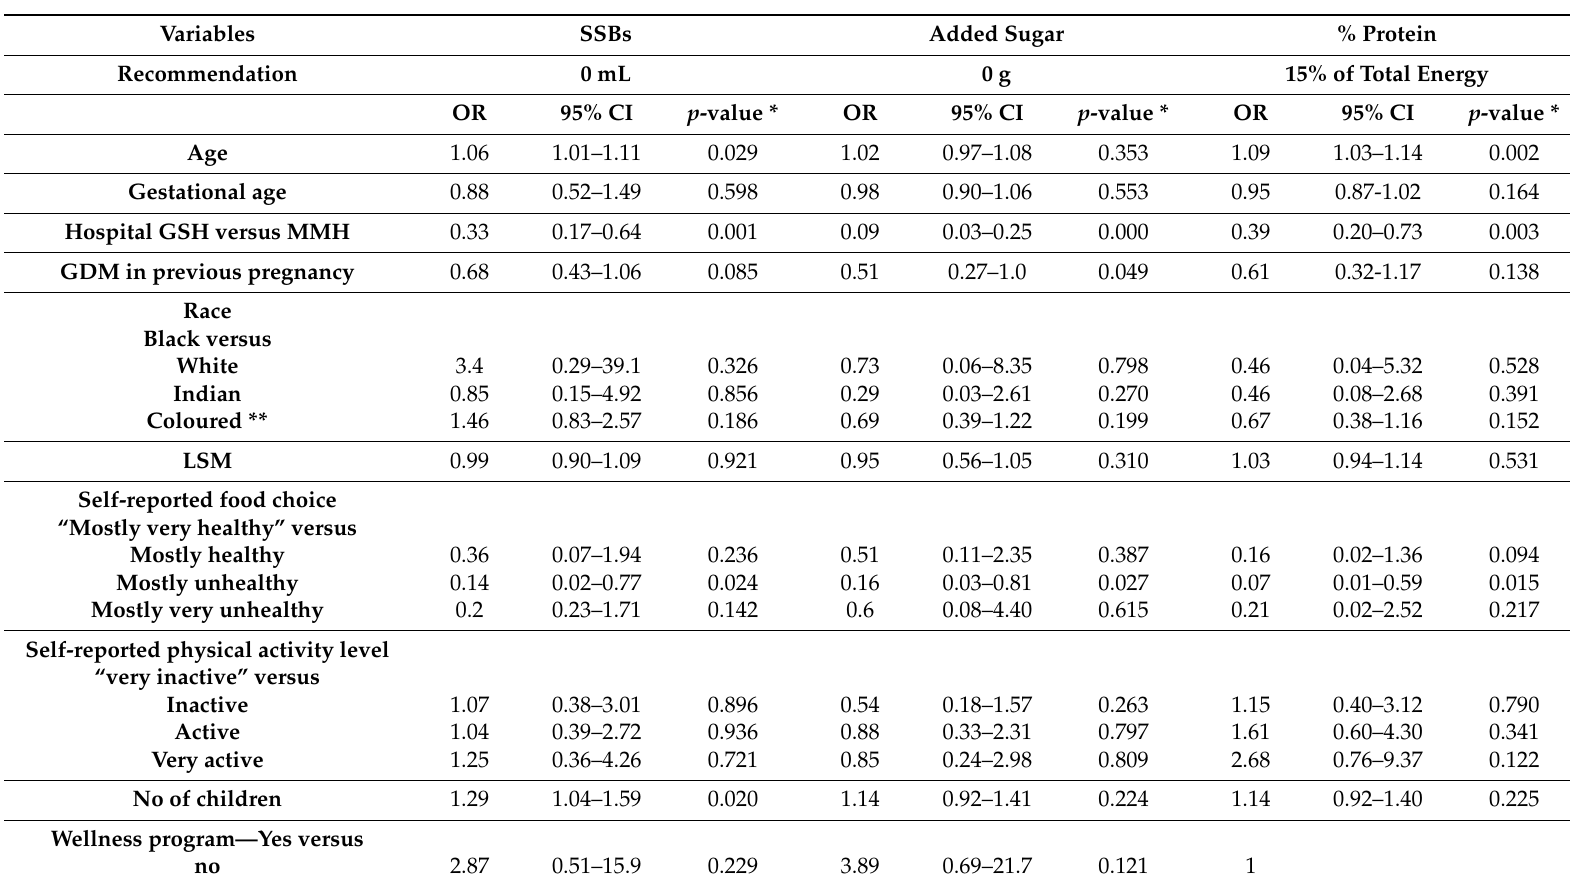
Table 6. The Univariate association between sociodemographic factors and the proportion of participants consuming the recommended intakes of SSBs, added sugar and